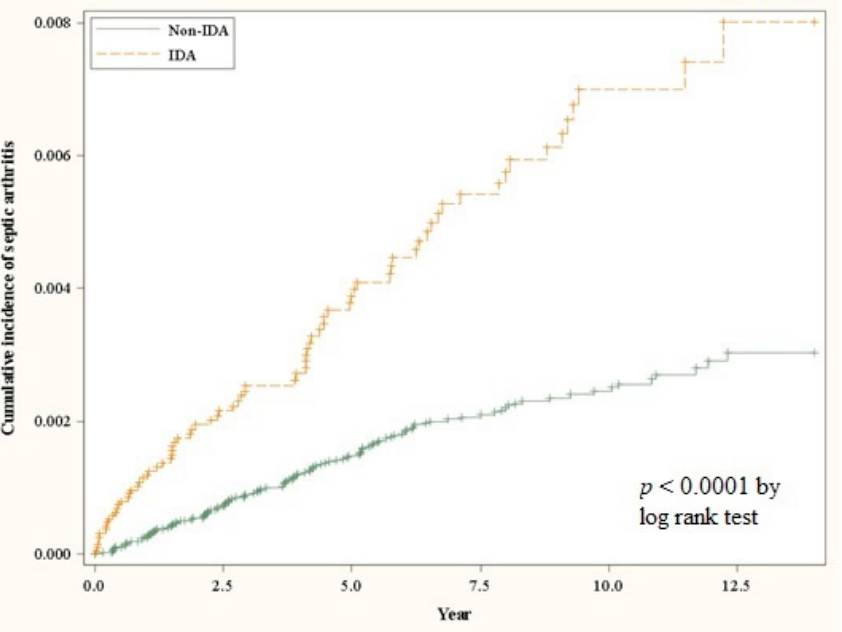
Figure 1. The cumulative incidence curves for the occurrence of septic arthritis for the IDA and control cohorts. Table 3 compares the incidence and adjusted hazard ratio (aHR) of SA between the IDA and the control cohorts stratified by age, gender, comorbidities, and treatment in baseline. The impact of IDA on the occurrence of SA is more prominent (aHR > 2.53) among the subjects with the age of 40–64 years (aHR: 2.89, 95% CI: 1.69–4.97), with male gender (aHR: 3.04, 95% CI: 1.97–4.67), with hypertension (aHR: 2.75, 95% CI: 1.88–4.01), with hyperlipidemia (aHR: 2.79, 95% CI: 1.53–5.09), with COPD (aHR: 2.76, 95% CI: 1.49– 5.13), and with chronic hepatitis (aHR: 3.78, 95% CI: 1.76–8.13). Table 4 compares the incidence and aHR of SA between the IDA and the control co- horts stratified by the duration of follow-up and age. Among the subjects aged between 40–64 years, the impact of IDA was accentuated (aHR > 2.53) when follow-up duration is more than 5 years (aHR: 4.49, 95% CI: 1.94–10.35). We conducted a sensitivity analysis regarding the association between IDA and in- fections (ICD-9-CM: 001–041, 045–139, 320–321, 323.0–323.4, 324, 420–421, 422.0, 422.92, 460–466, 475, 478.20–478.24, 480–487, 510, 511.0–511.1, 513, 522.4–522.7, 523.3–523.5, 527.3, 528.3, 569.5, 572.0, 590, 595.89, 595.9, 597.0, 599.0, 601, 604, 614–616) other than SA to elu- cidate the impact of IDA on general infection sensitivity (Table 5). The incidence of infec- tion in the IDA cohort and in the control cohort was 10.37 and 9.67 per 100 person-years, respectively. After adjustment for gender, age, comorbidities, and treatment in baseline, IDA patients had a 1.07-fold risk of infection when compared to the control subjects (aHR: 1.07, 95% CI: 1.04, 1.09).